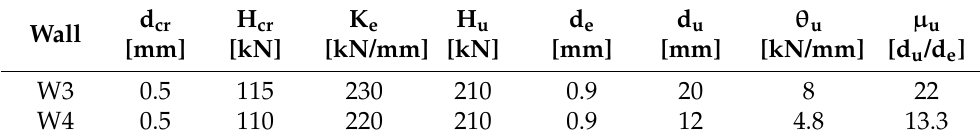
Table 10. Results of bilinear idealization for jacketed walls W3 and W4 ( σ v = 0.8 N/mm 2 ). Wall